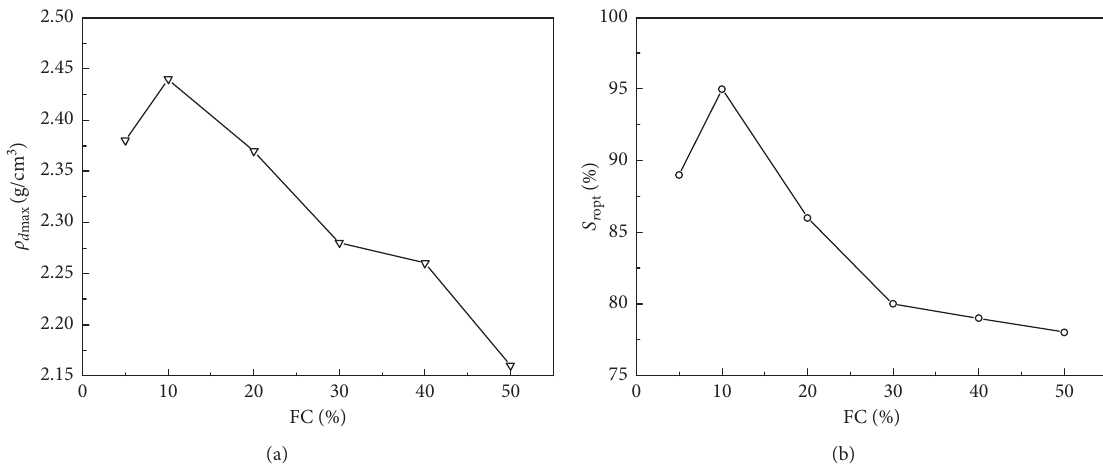
Figure 9: Compaction characteristics of tested gravel samples with different fine contents: (a) maximum dry density plotted against FC; (b) optimum saturation degree plotted against